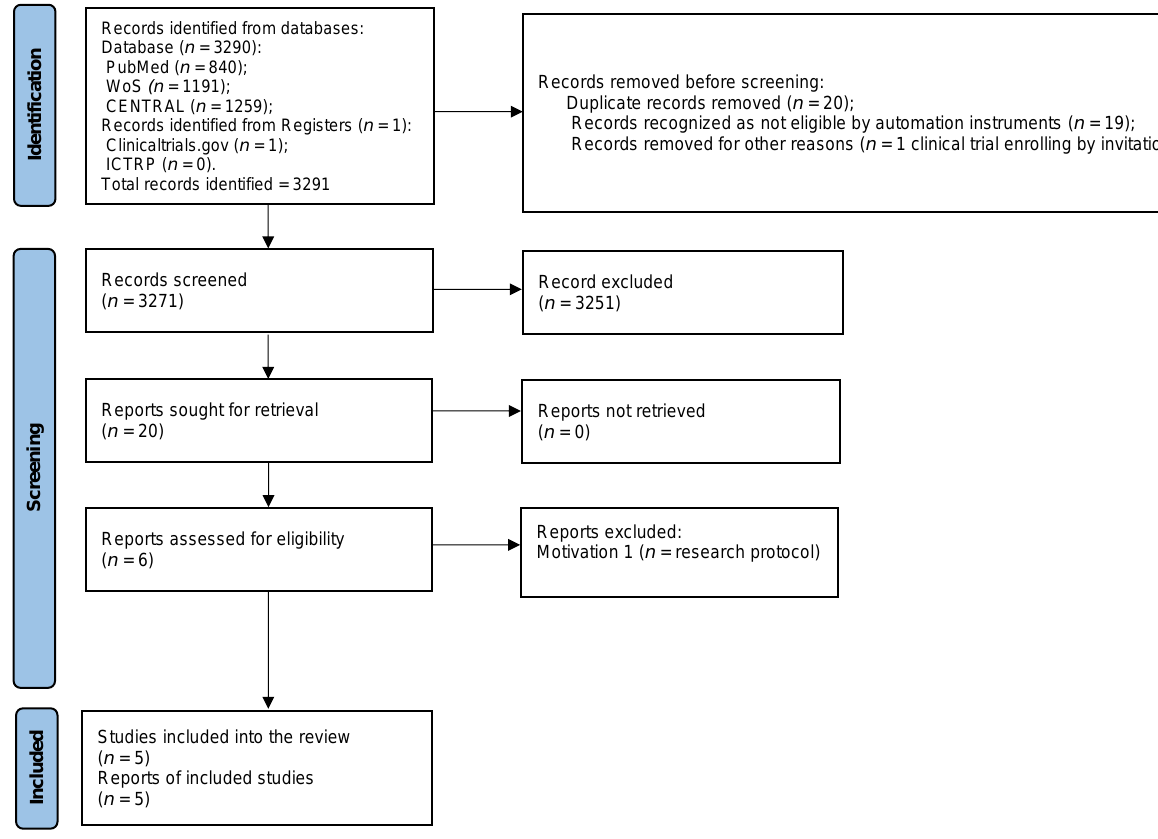
Figure 1. The PRIMA flow